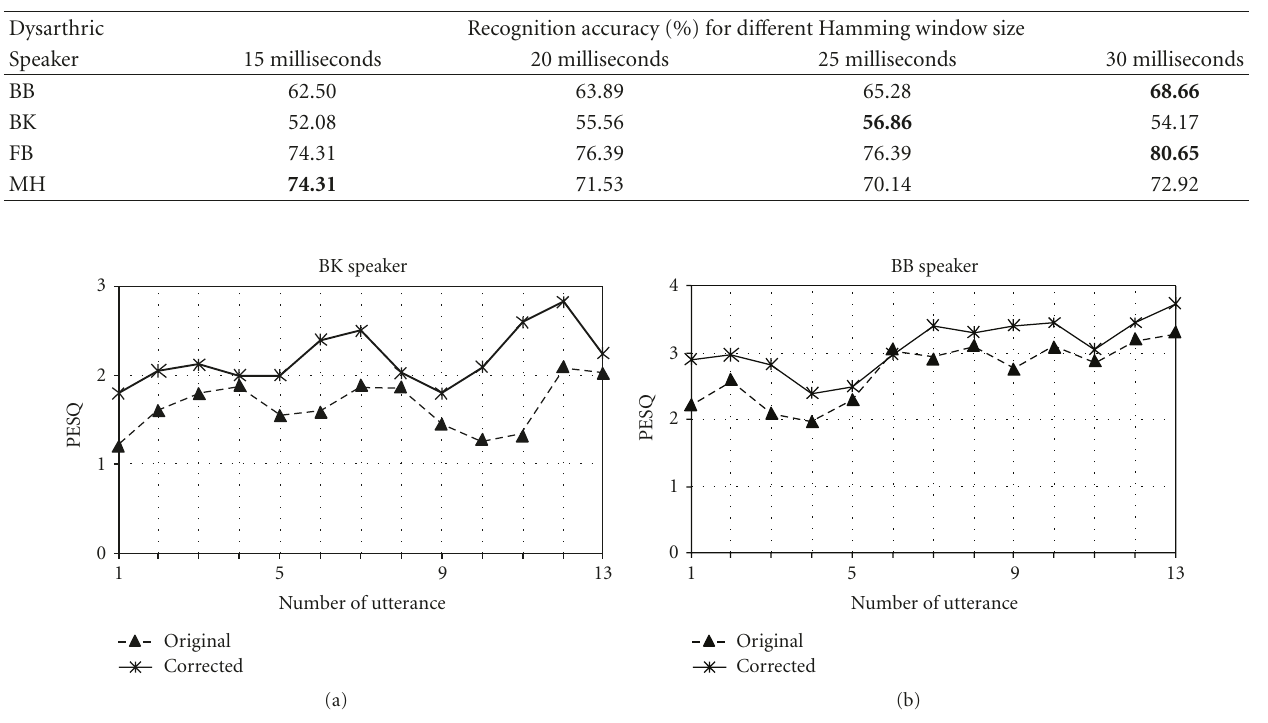
Figure 8: PESQ scores of original (degraded) and corrected utterances pronounced by BK and BB dysarthric speakers.